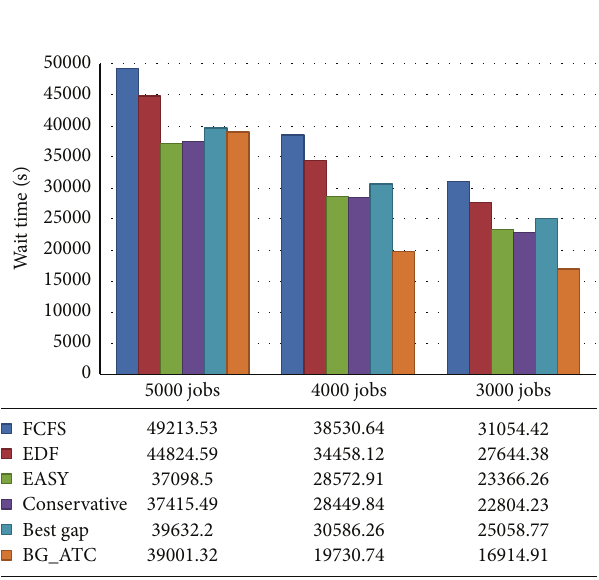
Figure 8: Wait time examination on metacentrum workload.